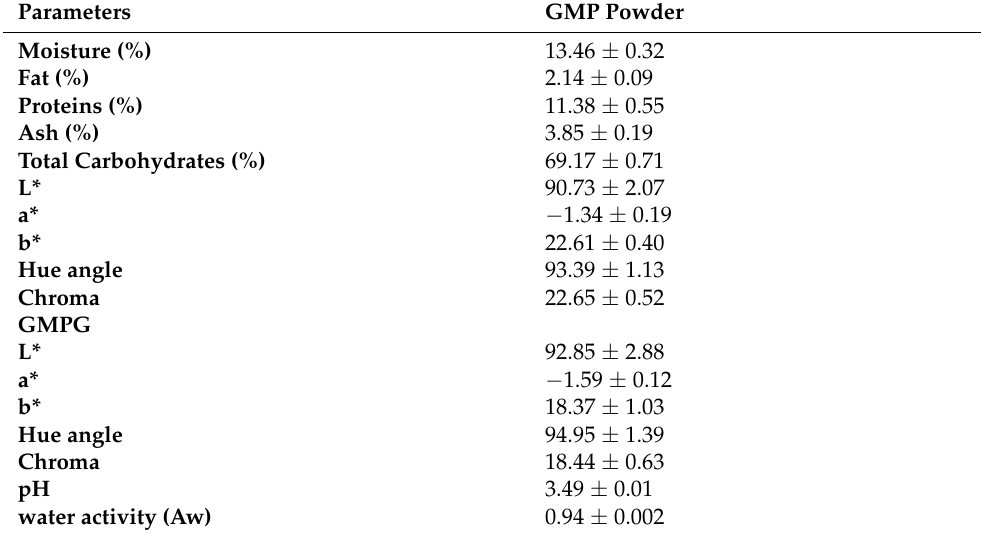
Table 2. Approximate chemical composition and color parameters (L*, a*, and b*) evaluated in Gurma melon pulp powder and color parameters (L*, a*, and b*), pH, and water activity (Aw) evaluated in fat replacer based on Gurma melon pulp